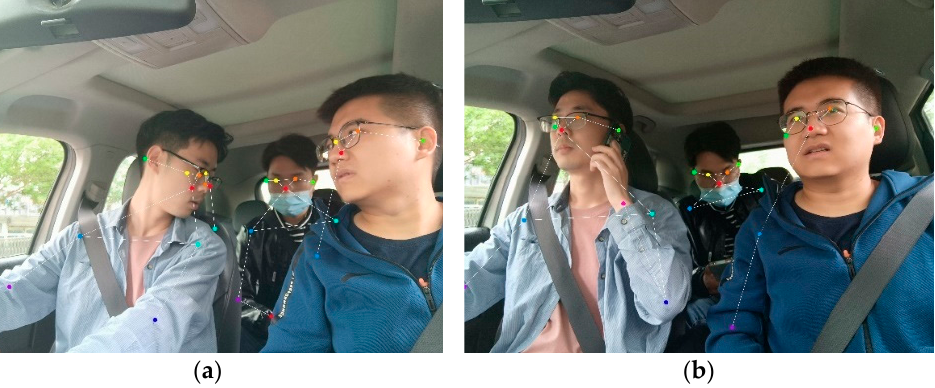
Figure 7. ( a ) Right turn (H) key point marker movement prediction; ( b ) answering the phone (E) key point marker action prediction.